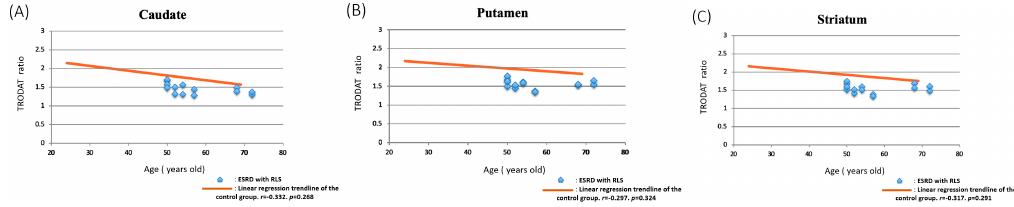
Figure 4. The linear regression of the caudate nucleus (A), putamen (B) and striatum (C) of the control